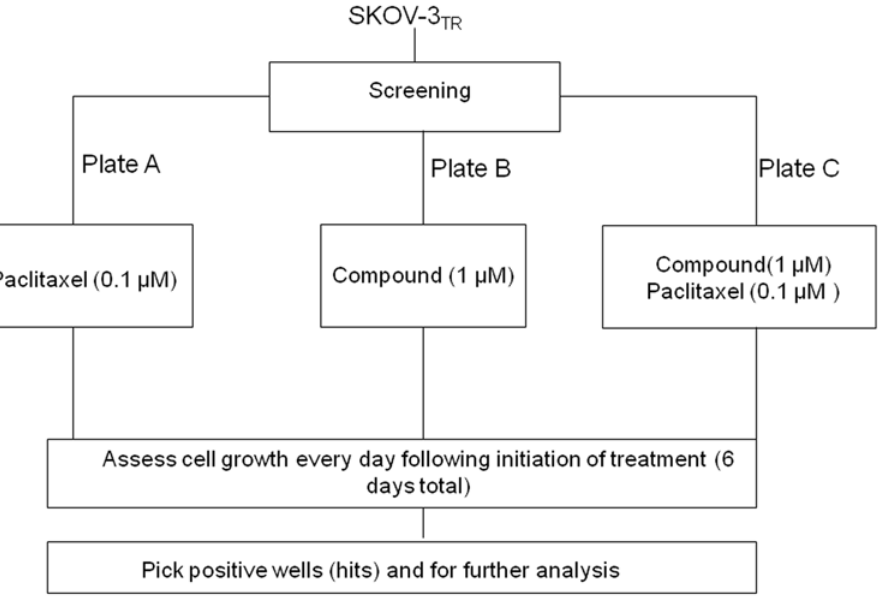
Figure 1. Flowchart of the screening small molecular compound to reverse drug resistance. For the screen, 2 6 10 4 SKOV-3 TR cells per well in 96-well plates were added with different NCI Diversity Set library compound and paclitaxel as indicated. After culturing for 6 days, the number of viable cells was analyzed using the CellTiter 96 AQueous One Solution Cell Cytotoxicity Assay and visualized under the microscope.